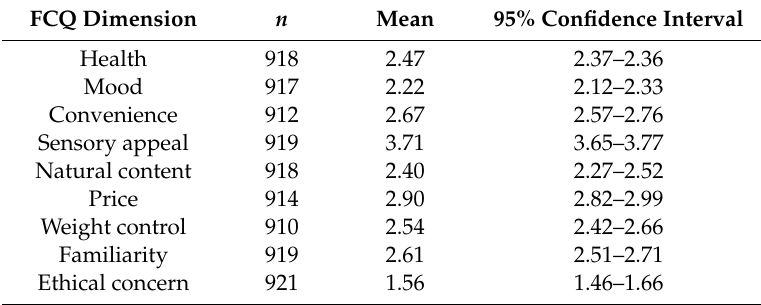
Table 2. Average scores of each dimension of the Food Choices Questionnaire (FCQ) in the population of manufacturing workers of Rio Grande do Norte, Brazil,